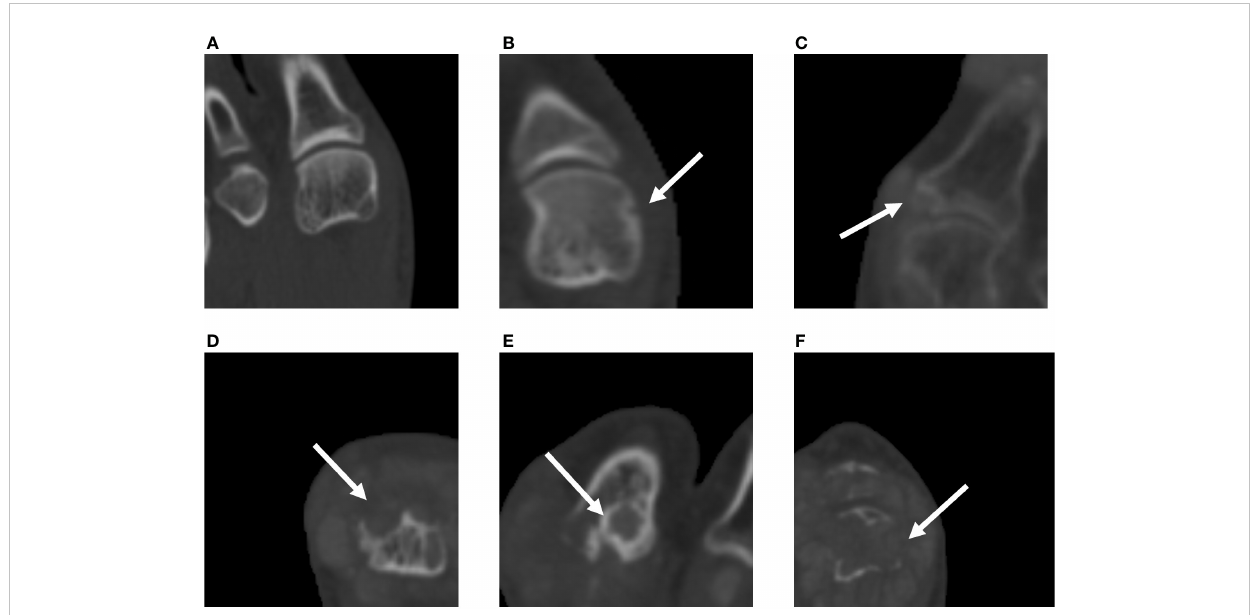
FIGURE 2 Assessment of bone erosion in the MTP joints with CT images using the modi fi ed SvdH erosion scoring method. (A) A score of 1 indicates tiny and discrete erosion. (B) A score of 2 indicates spread erosion. (C) A score of 3 indicates an erosion surface nearly half of the joint surface. (D) A score of 4 indicates erosion exceeding half of the joint surface. (E) A score of 5 indicates extensive bone erosion and loss. SvdH, Sharp/van der Heijde; CT, computed tomography; MTP, metatarsophalangeal